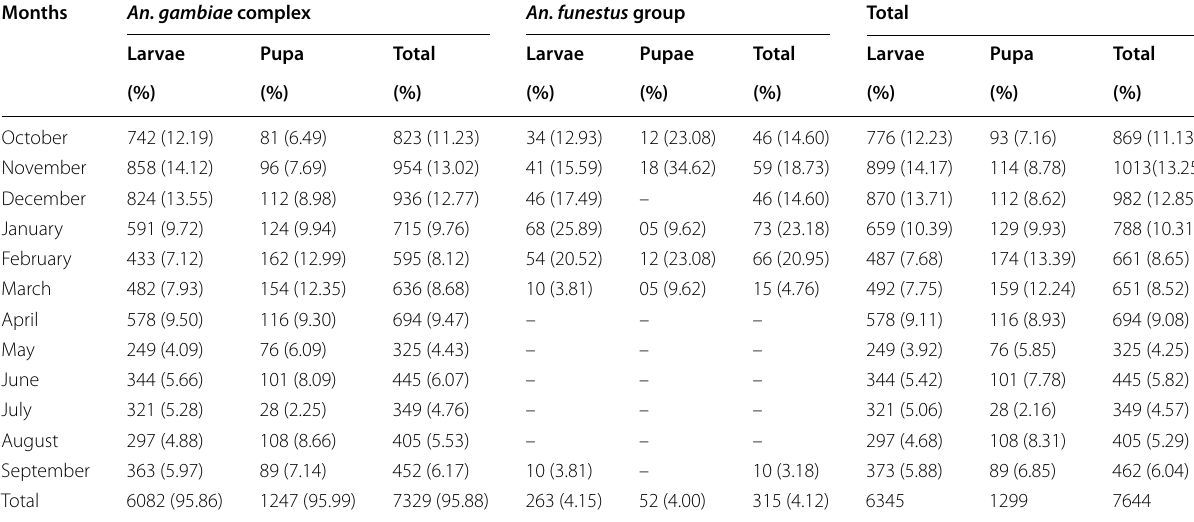
Table 1 Monthly collection of Anopheles mosquito larvae and pupae from habitats in the Study Areas (750 ml of water per collection) Months